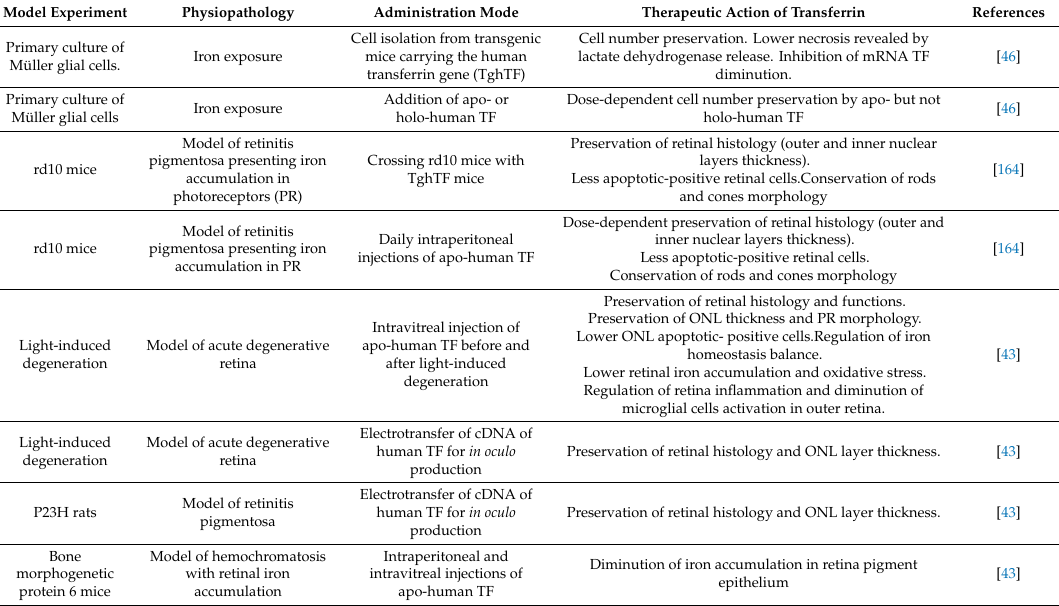
Table 3. Transferrin as a therapeutic drug in retinal diseases